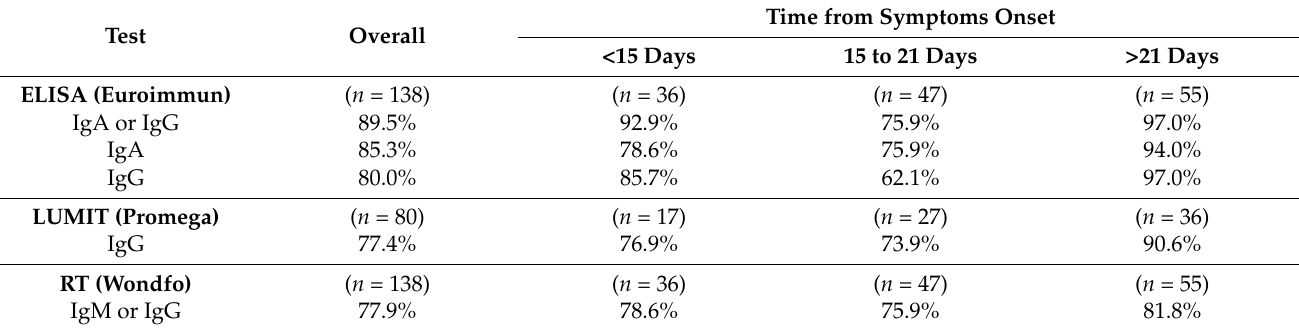
Table 2. Proportion of individuals with antibodies against SARS-CoV-2 according to RT-PCR test, from onset of COVID-19 symptoms.